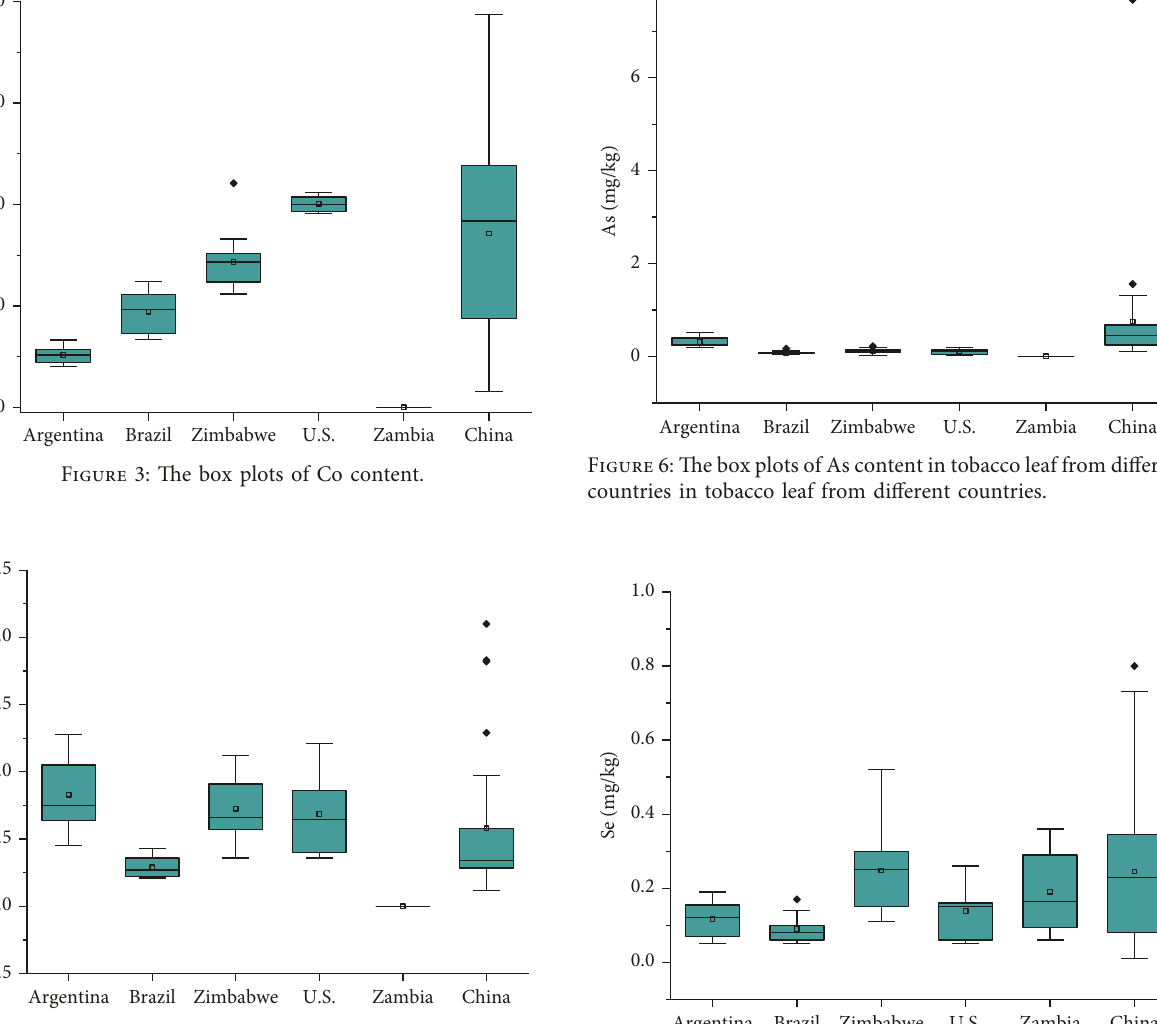
Figure 4: The box plots of Cr content in tobacco leaf from different countries in tobacco leaf from different countries.